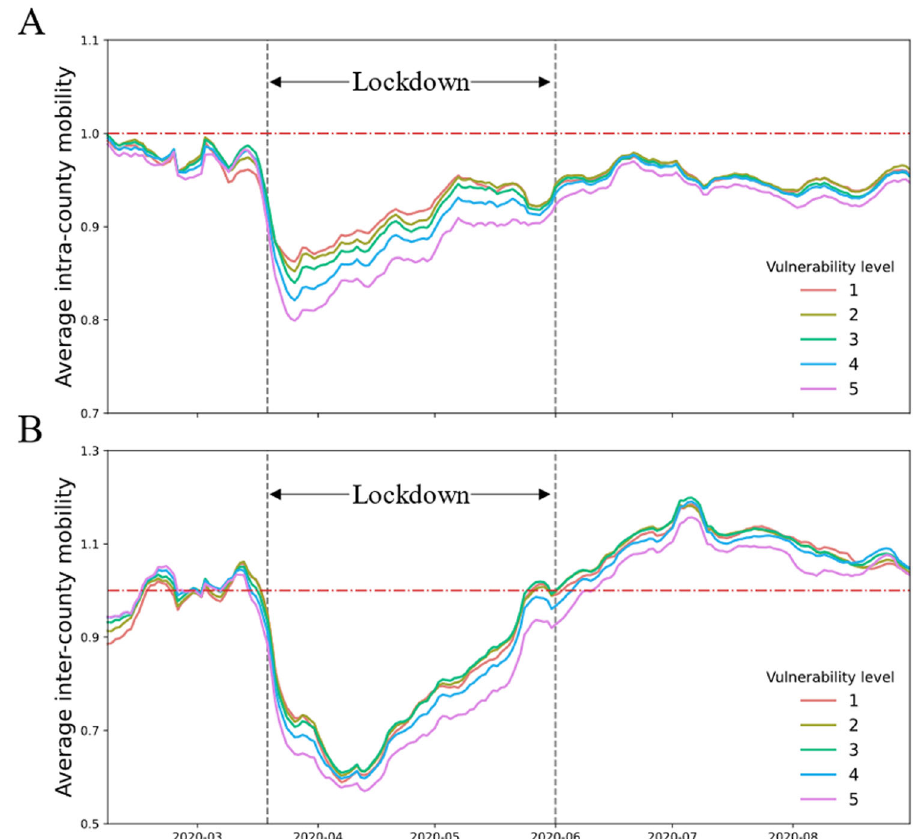
Fig. 4 Temporal variation in mobility across different vulnerability levels. Baseline value 1 is marked in red in the fi gure, and all mobility values are smoothed using a 7-day moving average. A The average changes in IntraM. B The average changes in (Table 3). Figure 6 shows the effects of IntraM and InterM on R t over different vulnerability levels (i.e., 1 to 5 from left to right).